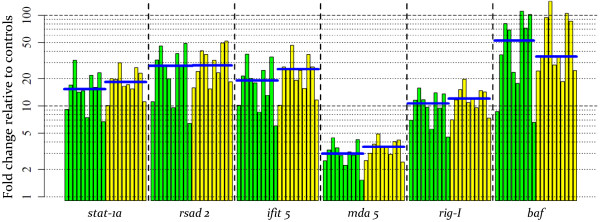
Assessment of individual expression of antiviral genes. Gene expression in 20 infected fish (from groups 3 + 4 at 4 wpi) is shown as fold change relative to uninfected controls based on real-time qPCR. The y-axis is plotted logarithmic. Bars are colored according to the histopathology score of atrium for respective fish; green = score 0, yellow = score 1. The median fold change for each histopathology score per gene is indicated with a blue line.